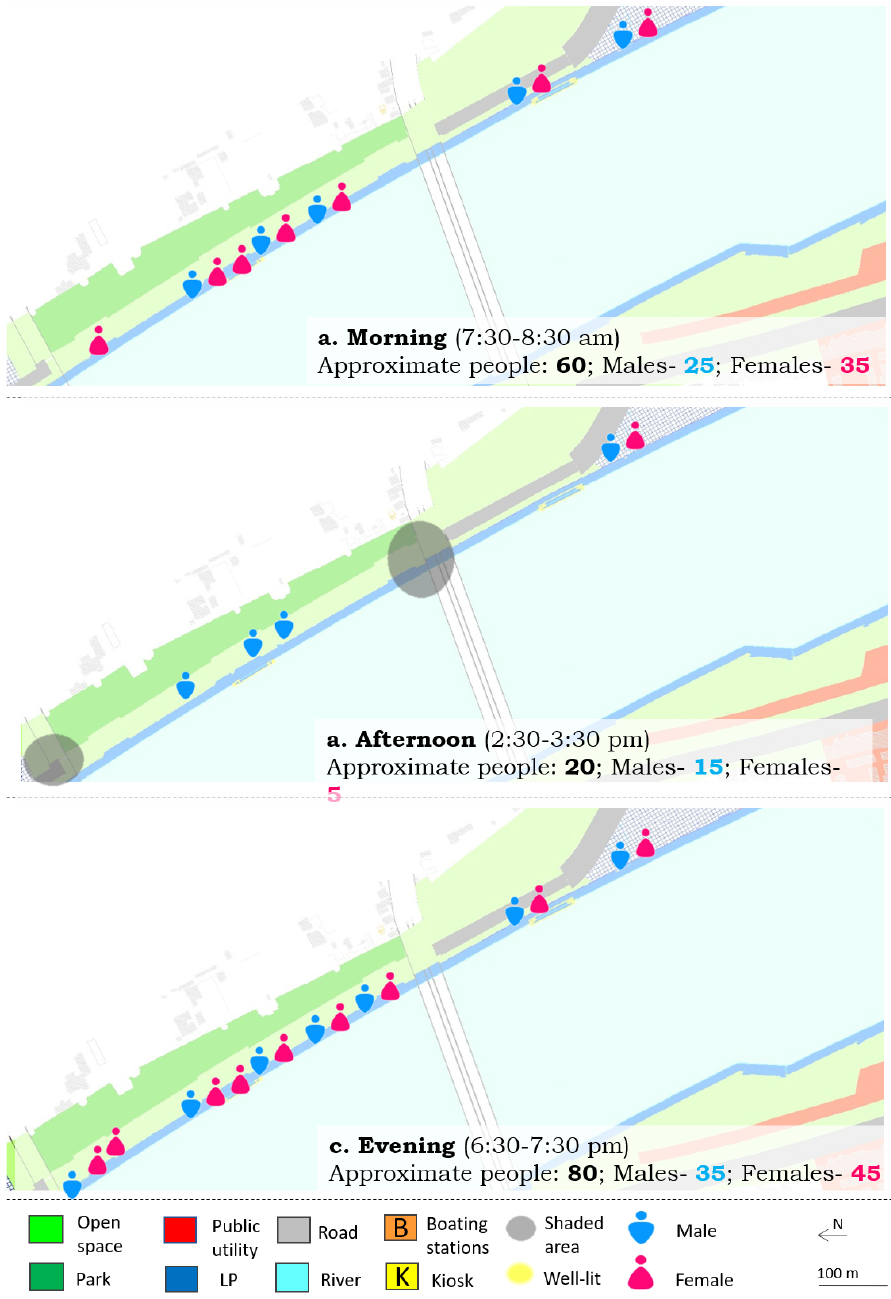
Figure 6. Gendered usage of space in Pocket